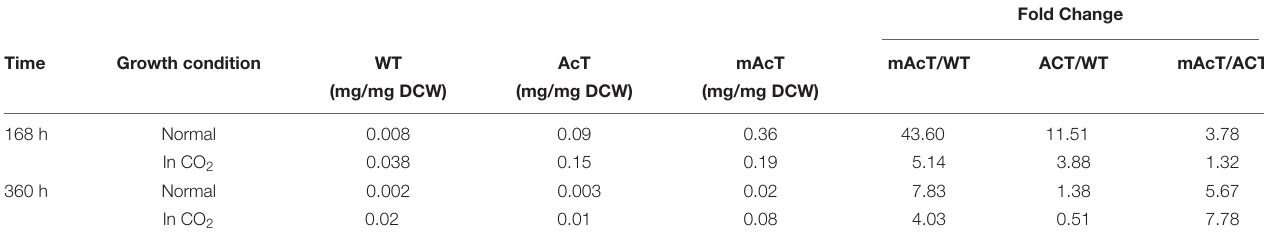
TABLE 4 | The ratio between extracellular FFA and dry cell weight calculated from cells grown under normal and CO 2 enriched conditions.